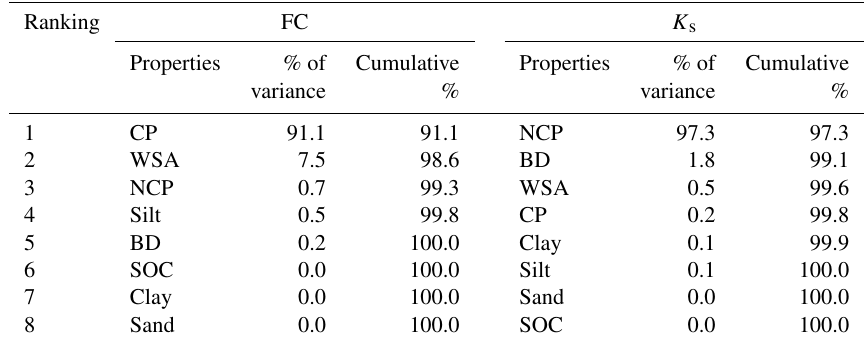
Table 4. Total variance of FC and K s explained by basic soil properties. Ranking FC K s Properties % of Cumulative Properties % of Cumulative variance % variance % 1 CP 91.1 91.1